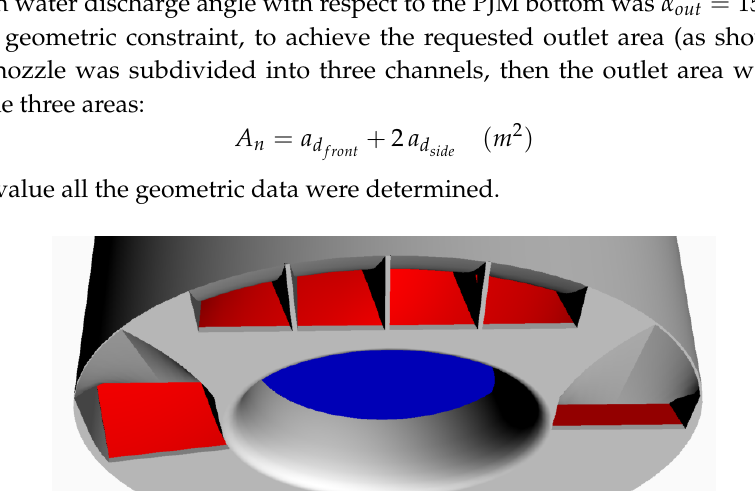
Figure 7. In red, the outlet areas are